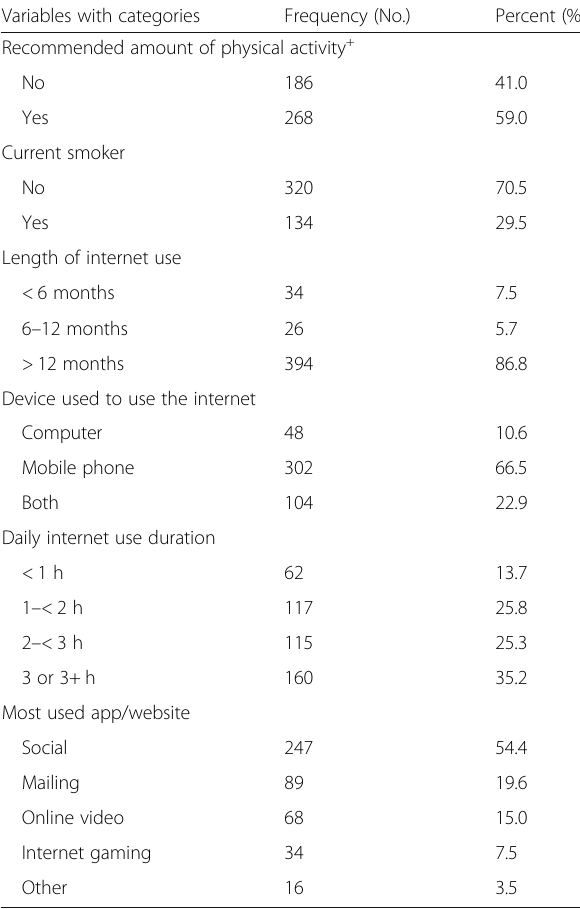
Table 1 Sociodemographic characteristics of young adult Table 2 Activity related characteristics of the young adult internet users of Bangladesh,